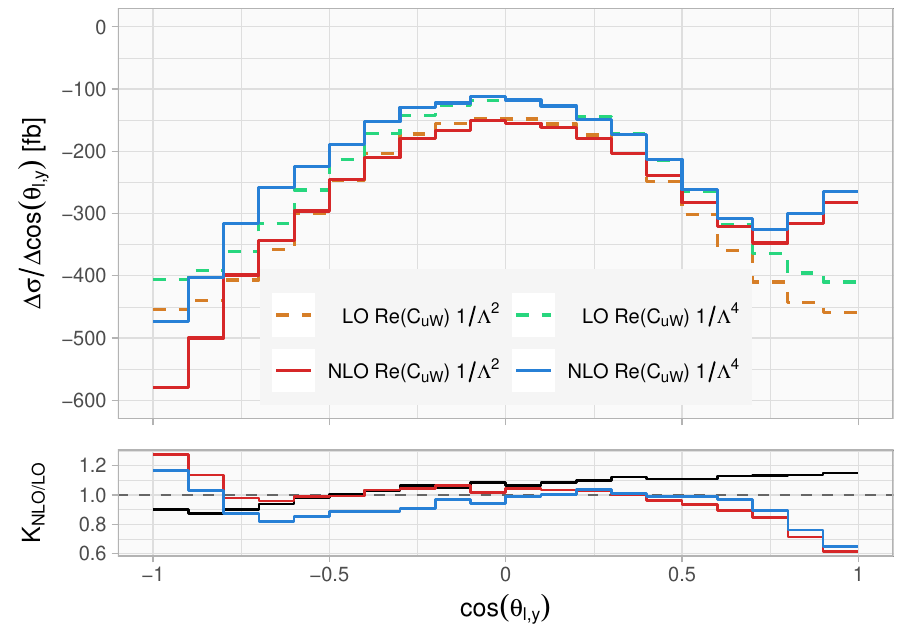
Figure 10. Distribution of cos (cid:18) l;y for the pure SMEFT contribution with Re C 33 1000 GeV. Shown are results at LO and NLO in QCD and at 1 = (cid:3) 2 in the SMEFT as well as with higher order e(cid:11)ects 1 = (cid:3) 4 .